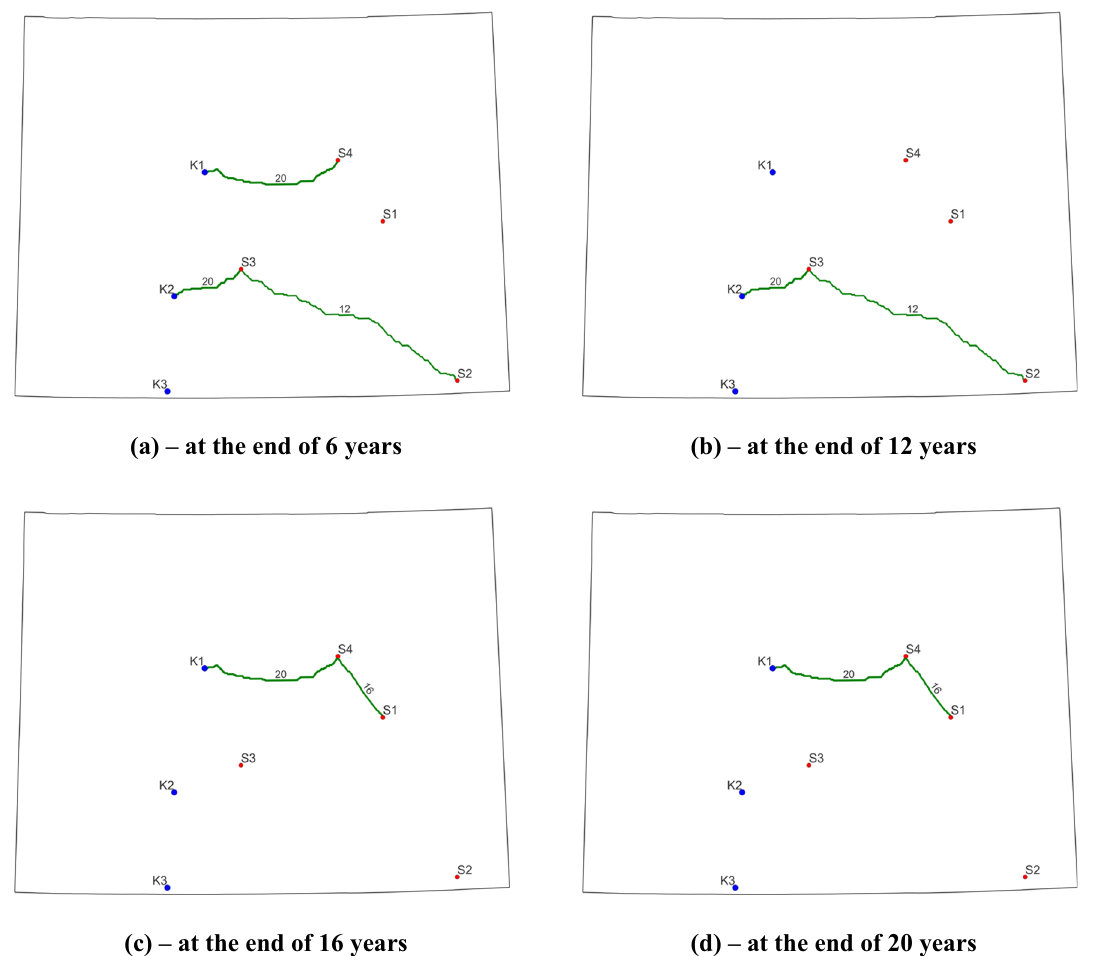
Figure 6. Final optimized CO 2 pipeline network for Case 5. Blue dots represent sinks, red dots represent CO 2 point sources, and green curves indicate the optimized pipeline routes (the number and thickness denote the pipeline